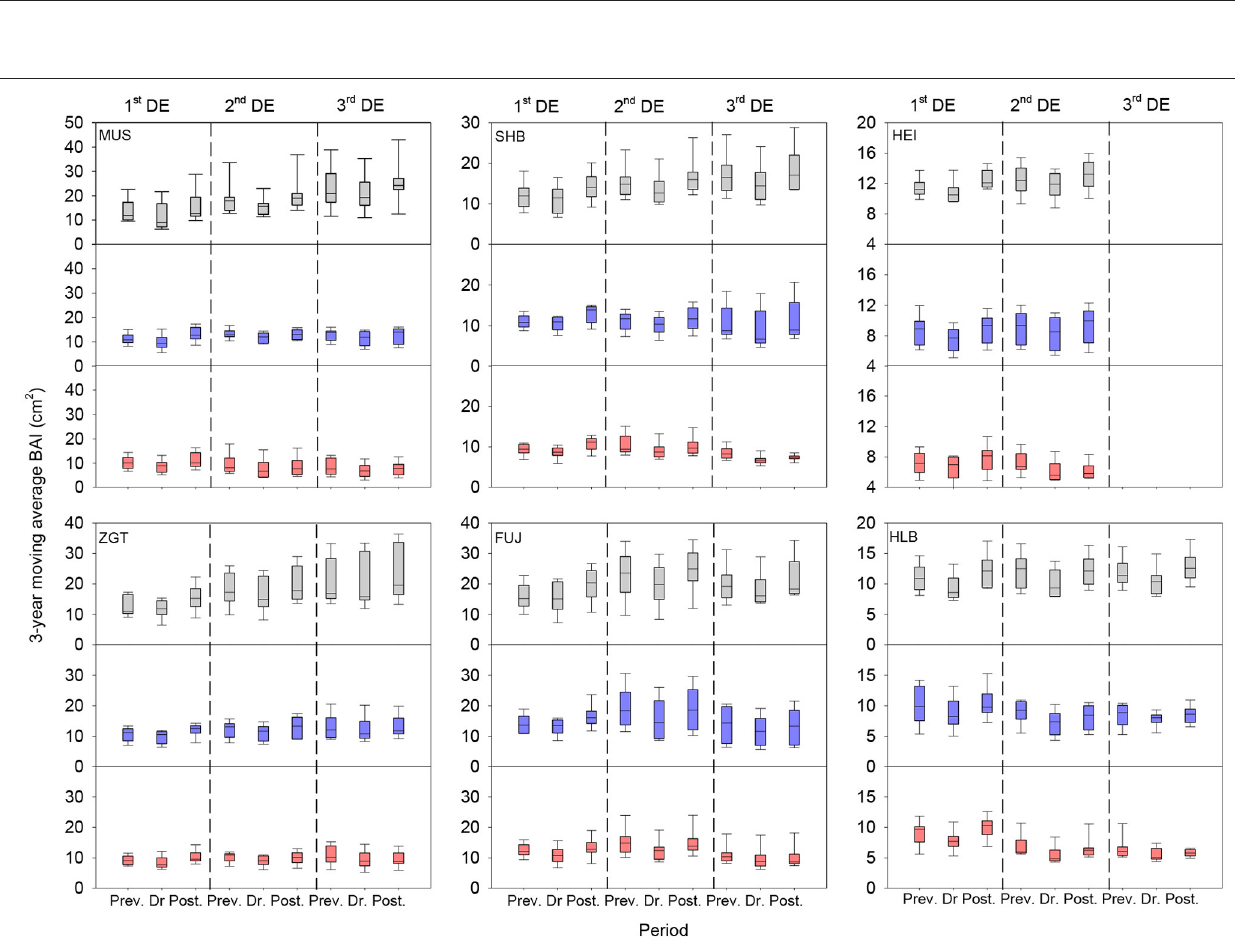
FIGURE 7 | Three-year moving average BAIs for the six Mongolian pine sites before, during, and after drought events. The boxplots show the mean values for all sites during the two or three drought events. DE represents drought event. Gray, blue, and red boxes represent the low-CI, medium-CI, and high-CI of Mongolian pine trees, respectively. CI, competition